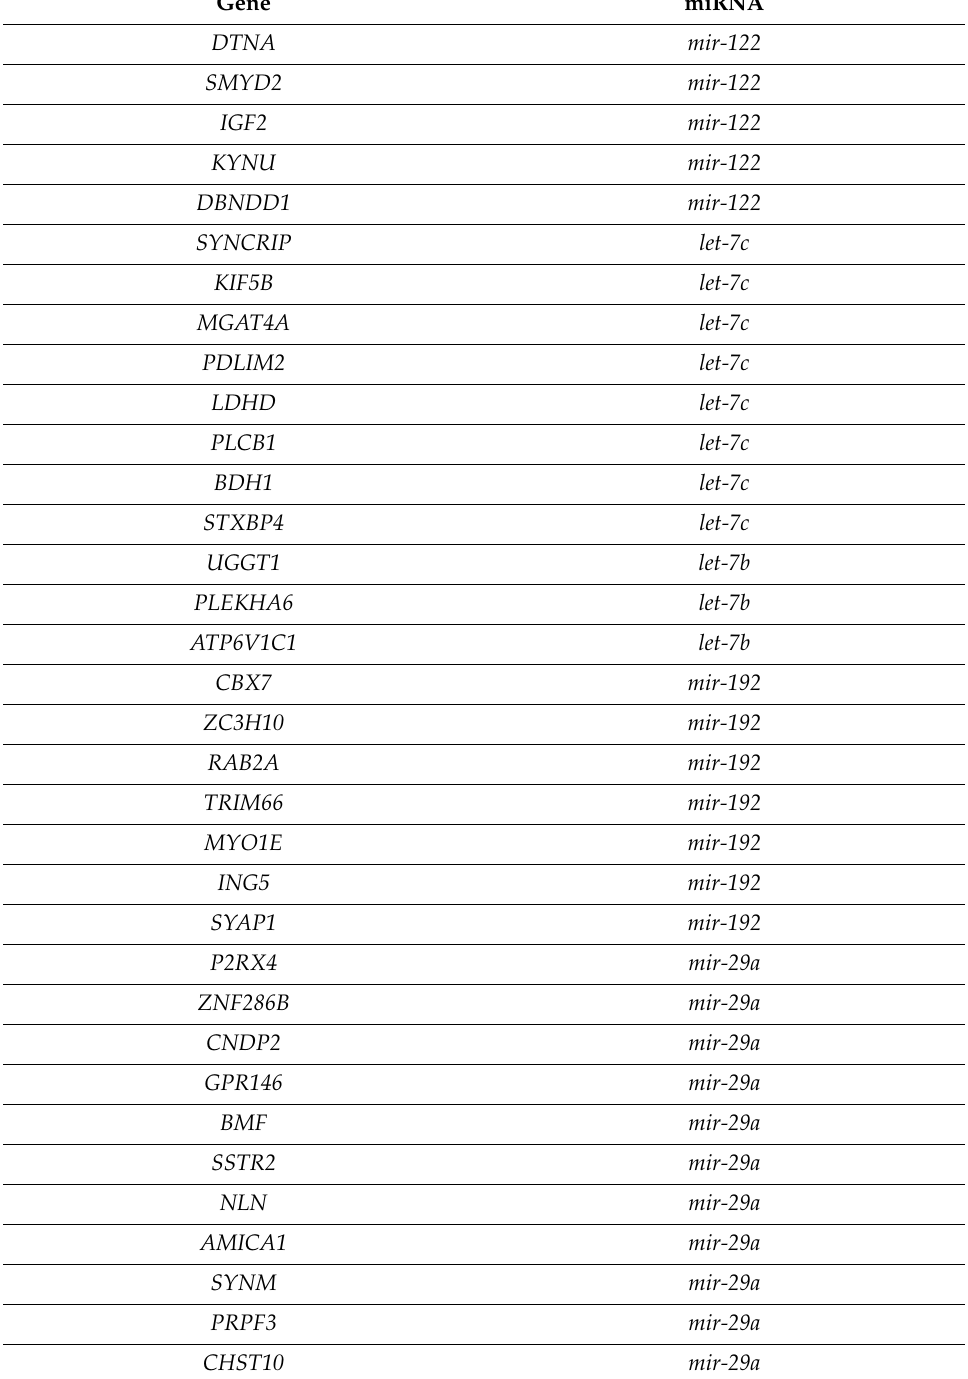
Table 4. A list of identified miRNAs and their targeted gene